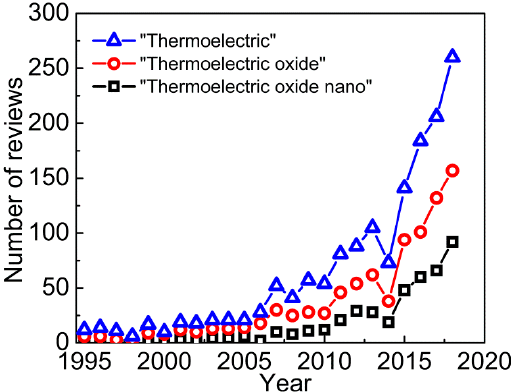
Figure 1. Statistics on review papers from 1995 to 2018 on ScienceDirect on queries “Thermoelectric”, ”Thermoelectric oxide” and “Thermoelectric oxide nano”.